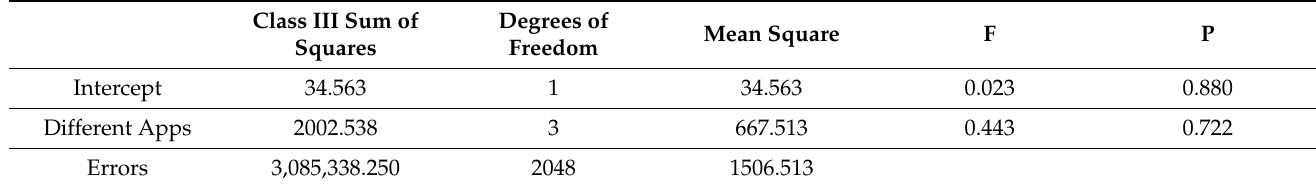
Table 7. ANOVA for different applications.